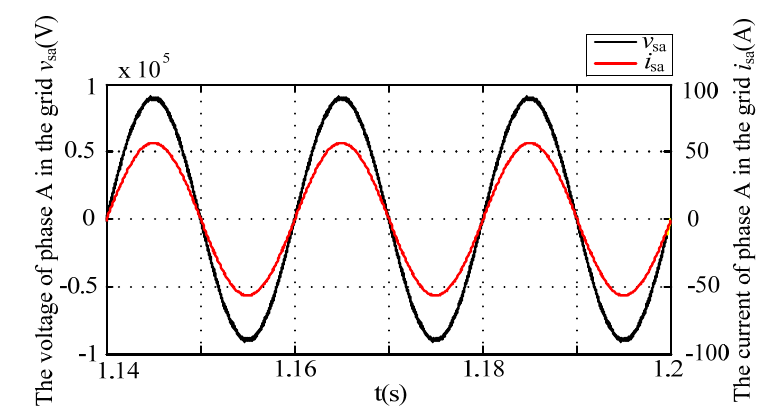
Figure 9. The currents in the grid.